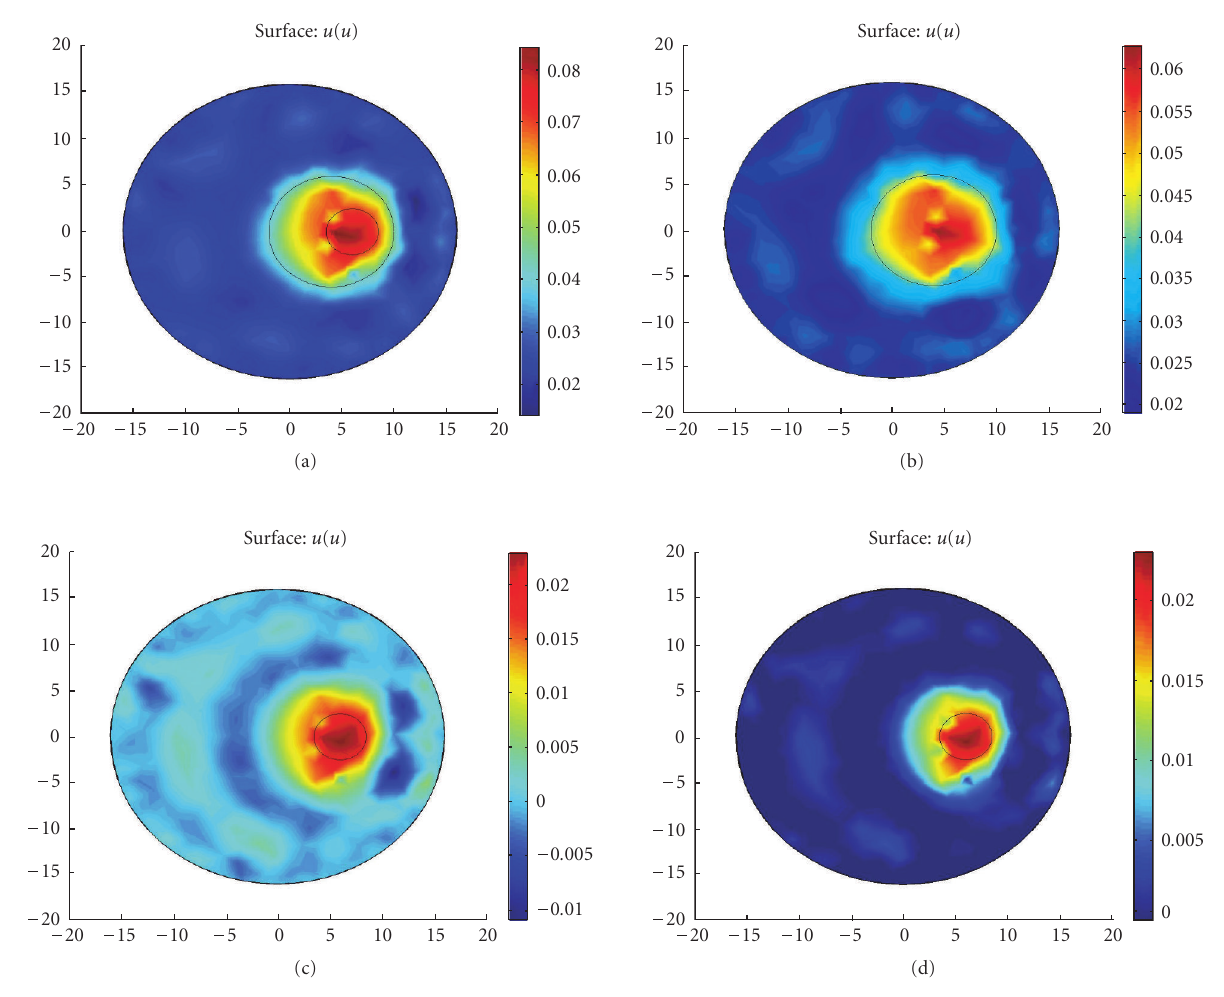
Figure 5: Images inversed when FA and HA intersect. (a) and (b) are, respectively, the independent reconstructed images of μ a ( r )+ ε c ( r ) and μ a ( r ). (a) minus (b) educed (c), describing the concentration of fluorochome. (d) constrained the negative values in (c) to zero. The black circles represent the original exact locations and shapes of HA and FA. The original μ a ( r ) is 0 . 05 mm (cid:0) 1 in the bigger 12mm-diameter circle centred at (4,0) and is 0 . 025 mm (cid:0) 1 in the rest. ε c ( r ) is 0 . 05 mm (cid:0) 1 in the inside 5mm-diameter circle centred at (6,0) and is zero in the